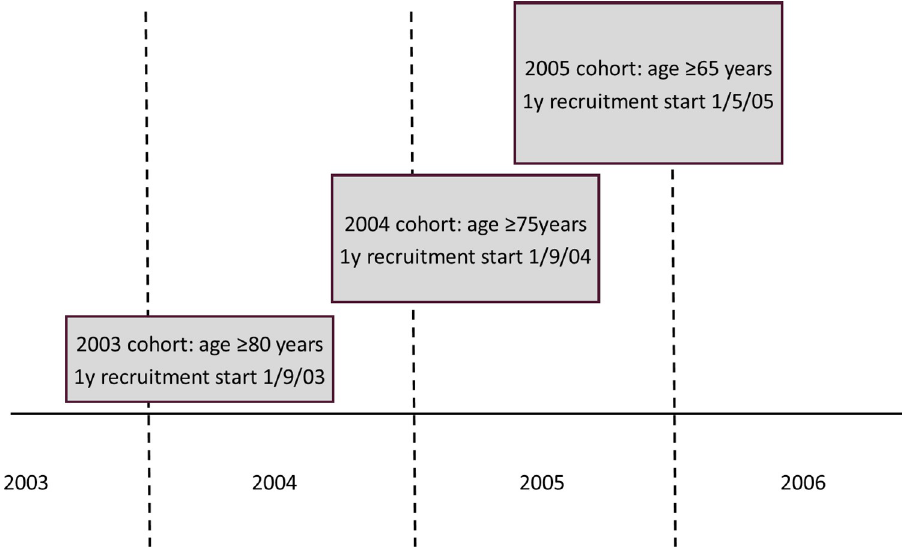
Fig 1. Diagram outlining recruitment of the three cohorts coinciding with stepped implementation of the policy to offer the vaccine to older adults, beginning with � 80y in 2003, then additionally the � 75y age group and finally all adults aged �